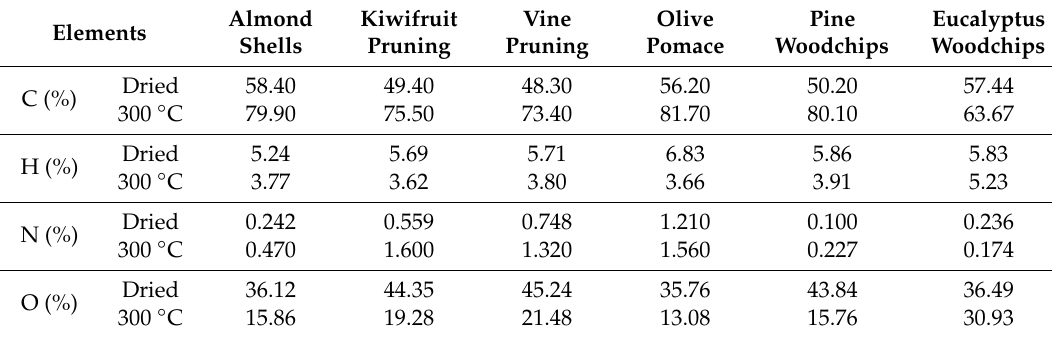
Table 2. Elemental analysis for the di ff erent biomass waste